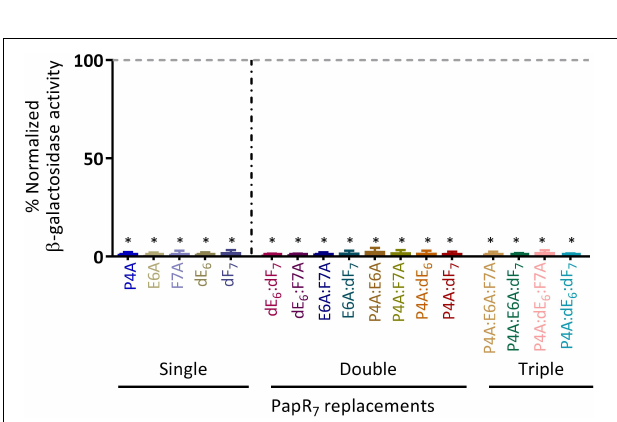
FIGURE 2 | PlcR regulon activation by the new PapR 7 -derived peptide combinations. β -galactosidase activity of Bt (cid:49) papR A’Z induced by the addition of 5 µ M PapR 7 -derived peptides normalized to synthetic PapR 7 signal peptide at onset of the stationary phase of bacterial growth (OD 600 of 3 ± 0.5, mean ± SEM, n = 9). ∗ p < 0.01 indicates a statistically significant difference between addition of synthetic PapR 7 peptide and PapR 7 - derived